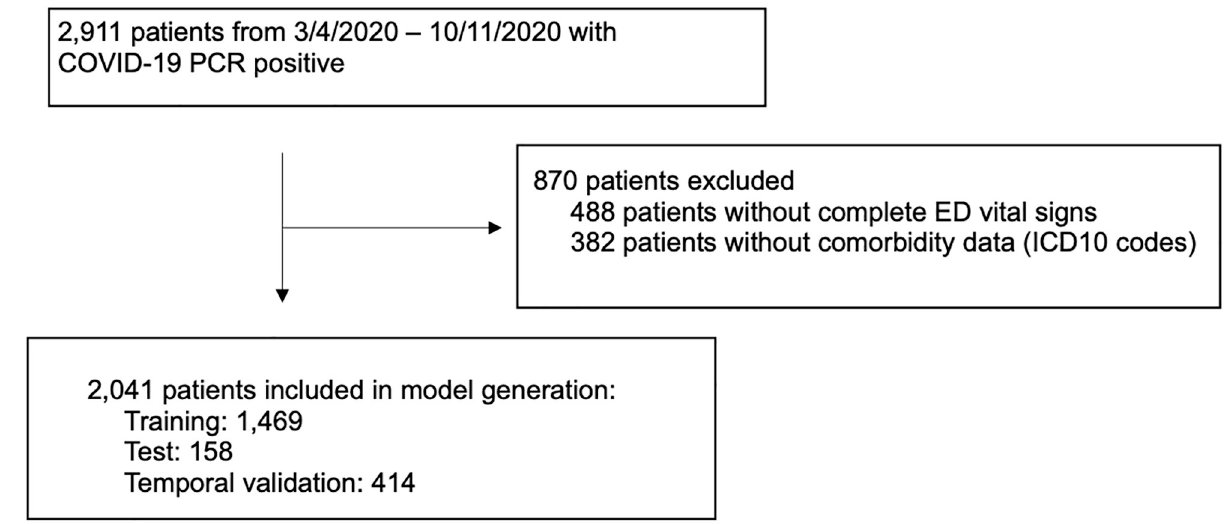
Fig 1. Study diagram detailing the selection of patients for model